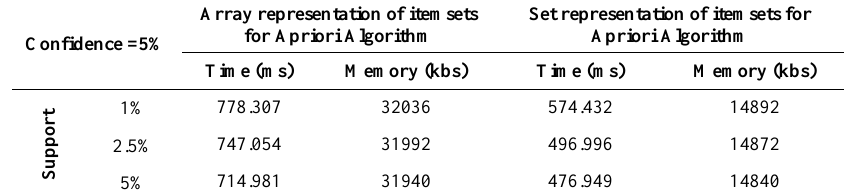
Table 7. The representation of itemset using Array and Set representation for Apriori Algorithm with confidence value=5 % and Support =1, 2.5, and